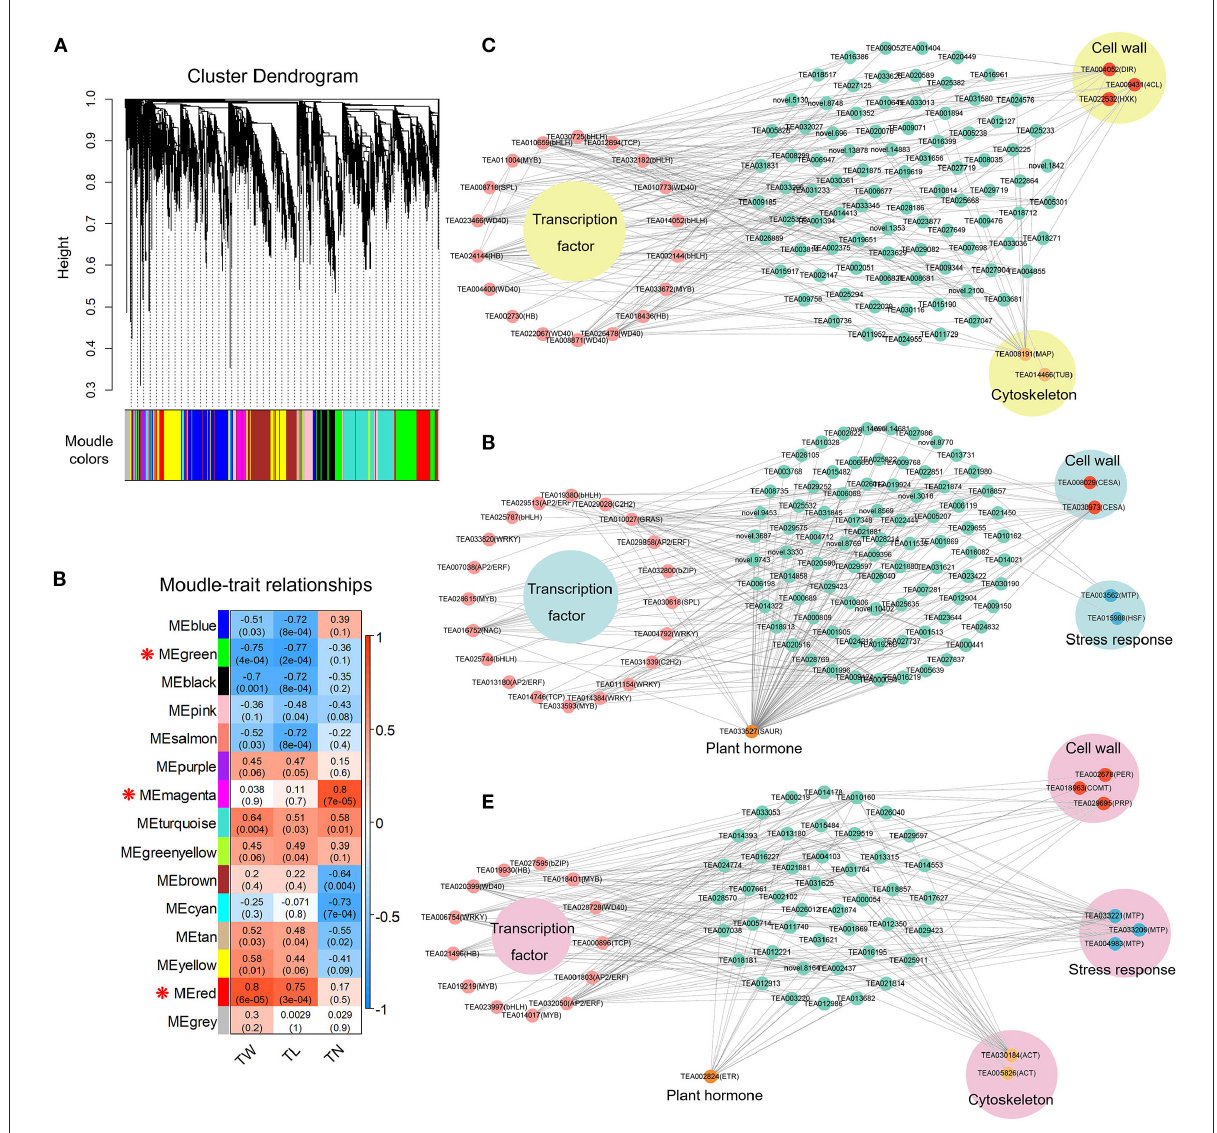
FIGURE11 Co-expression network analysis of tea plant trichome development. (A) Hierarchical clustering tree of the modules based on WGCNA analysis. (B) Relationships between modules and key traits in tested samples. (C) Co-expression network diagram of candidate genes in ME magenta module. (D) Co-expression network diagram of candidate genes in ME green module. (E) Co-expression network diagram of candidate genes in ME red